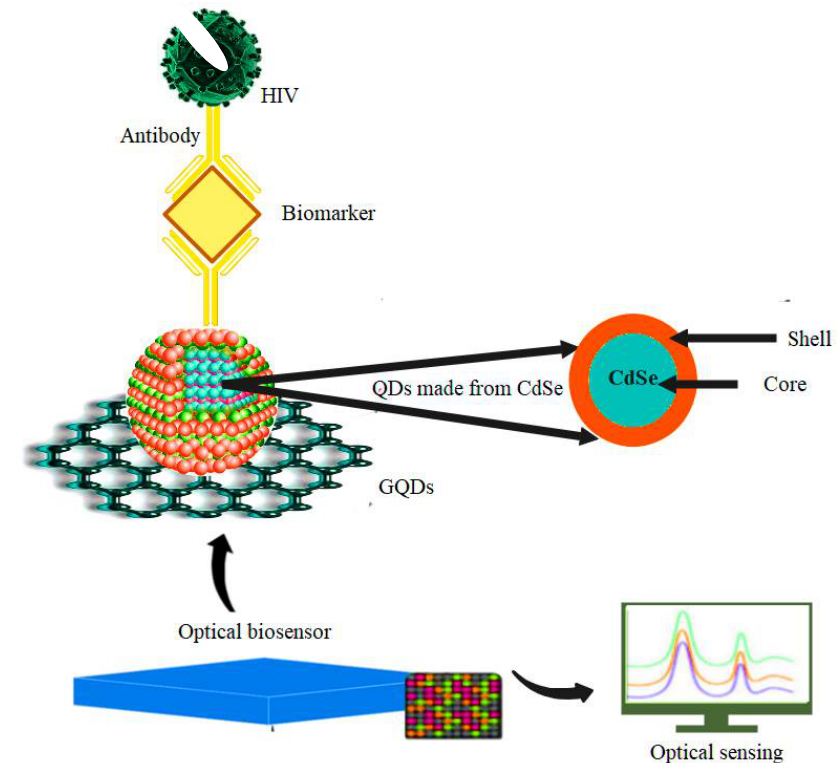
Figure 9. Detection of HIV by using QD-based biomarkers made from CdSe with optical sensors.